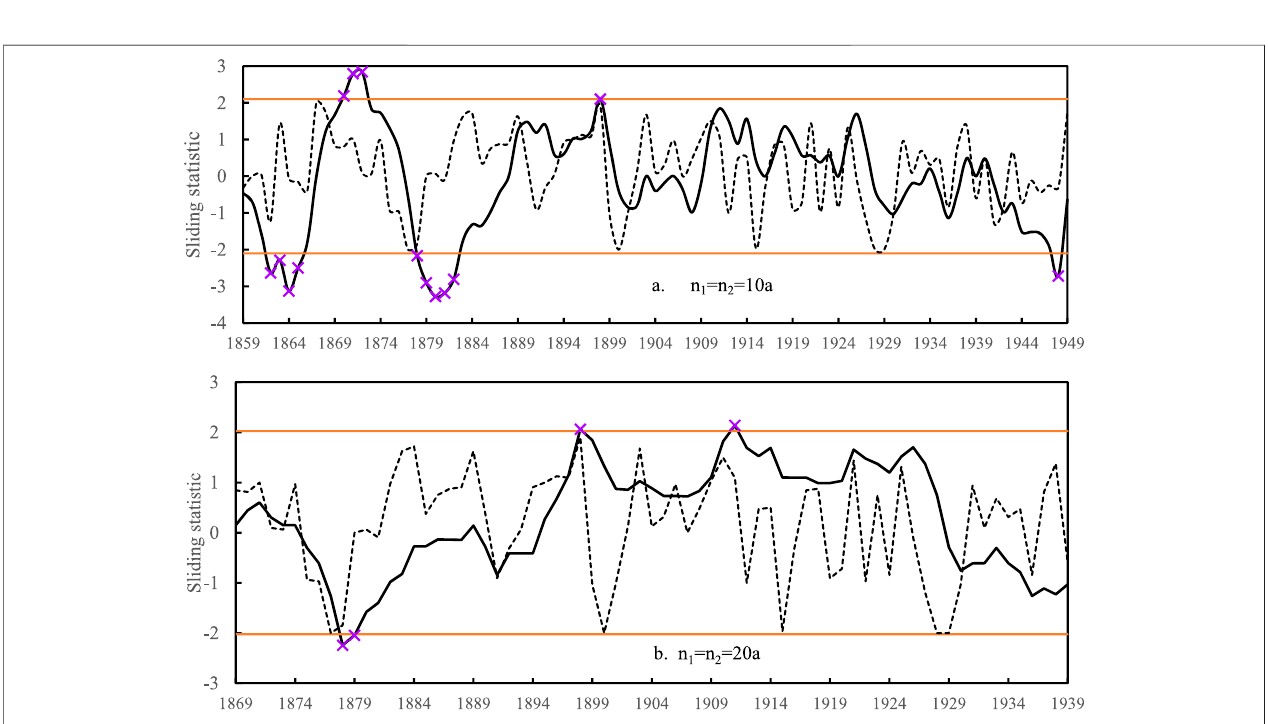
Frontiers in Earth Science |